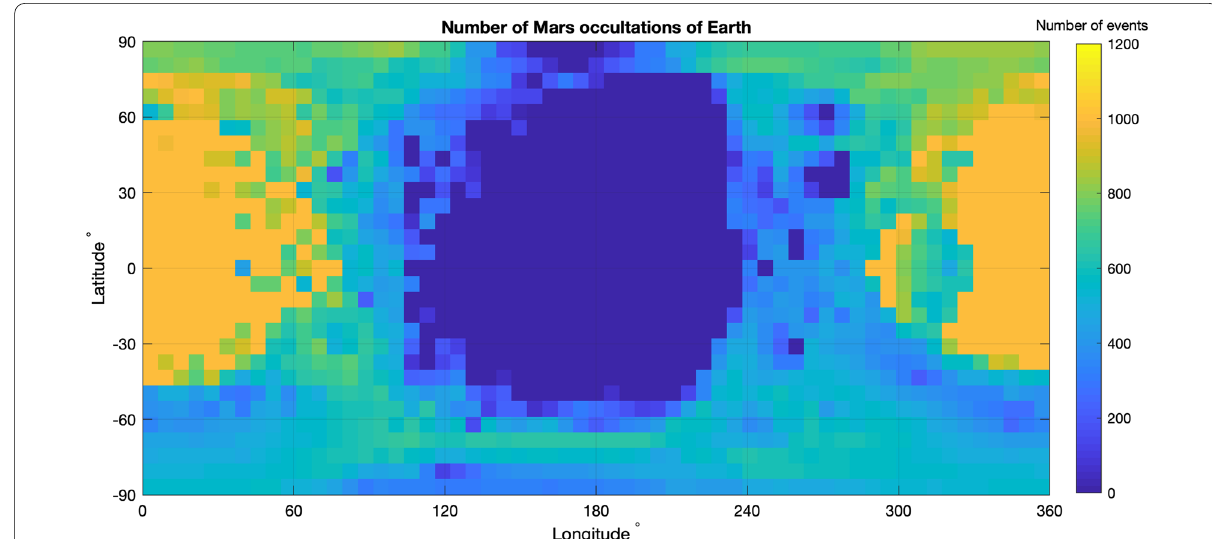
Fig. 10 Map of Phobos. Number of Mars occultations of Earth during the period 1 Jan 2030 – 18 Nov 2031